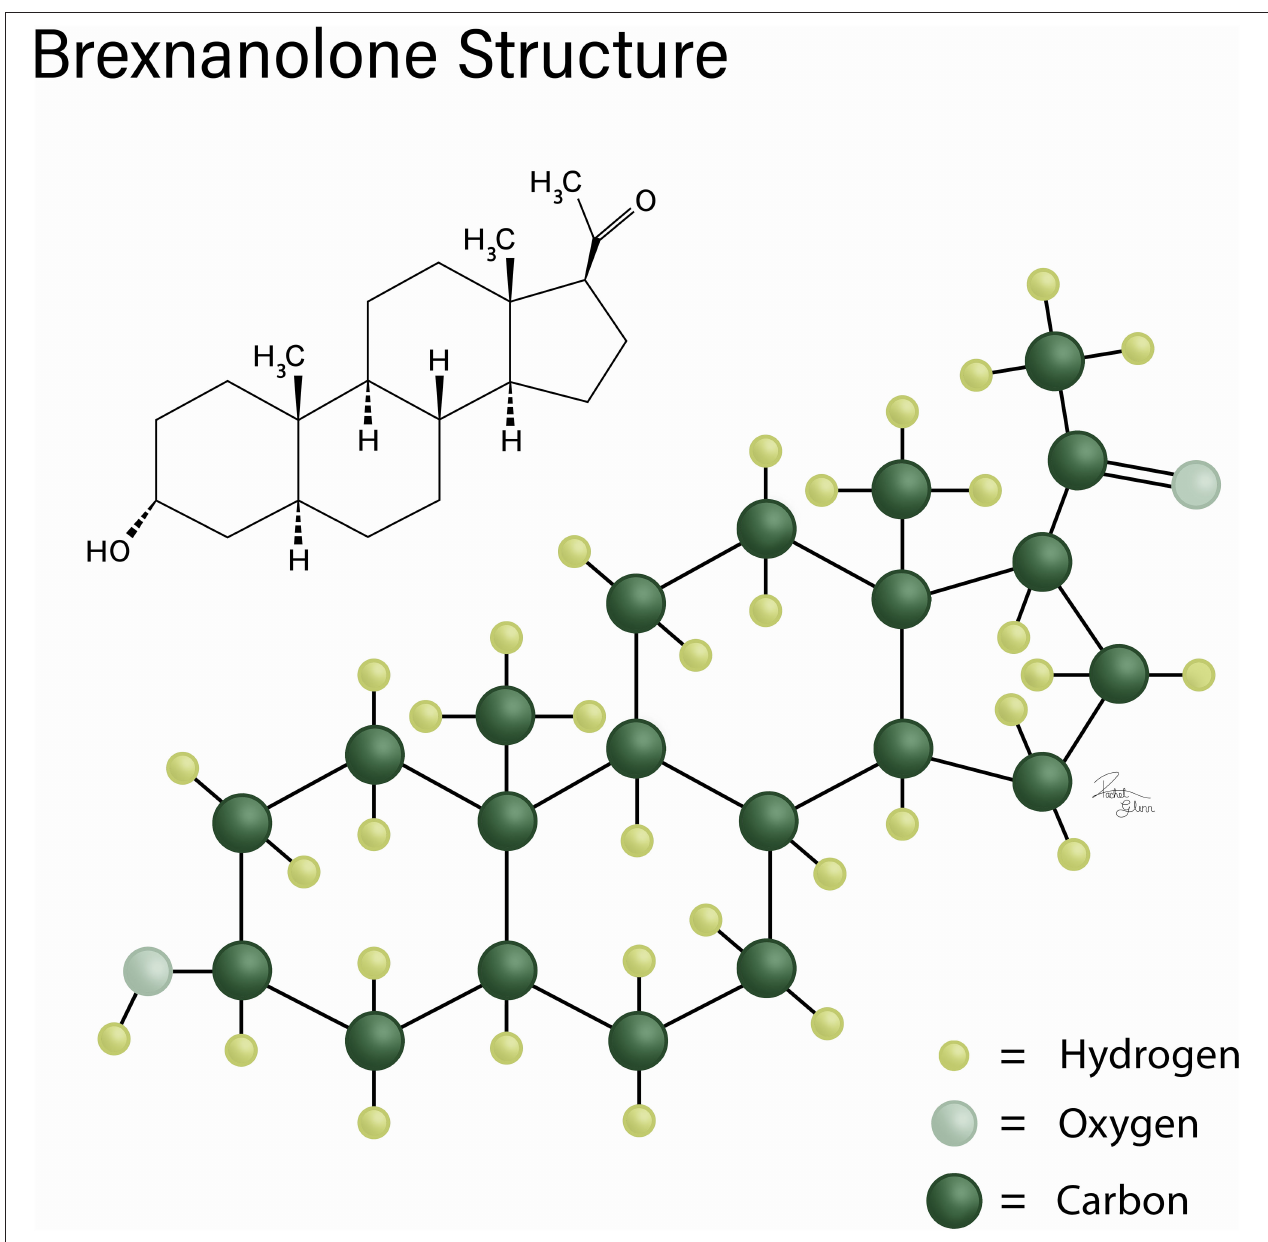
FIGURE 1 | Chemical structure of